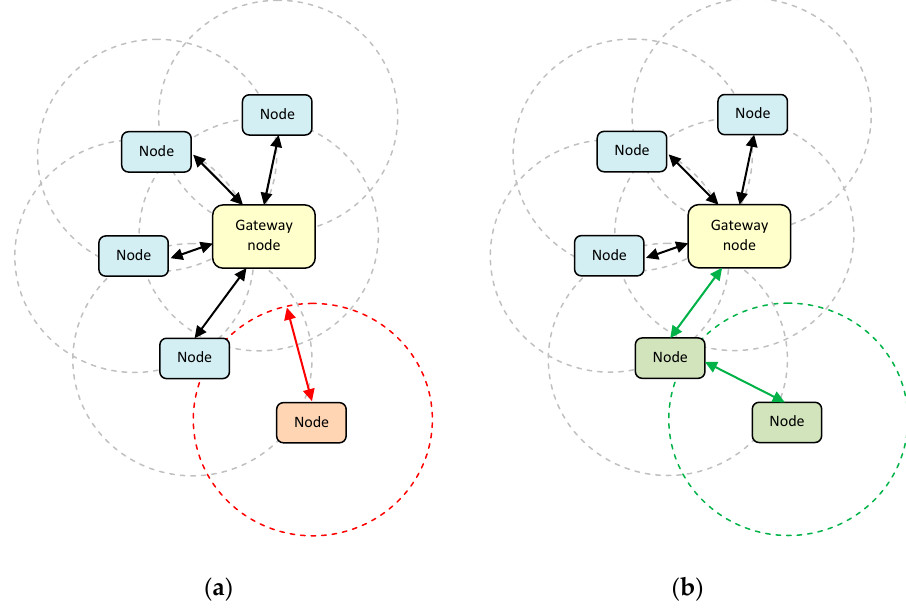
Figure 7. Direct ( a ) and indirect ( b ) types of communication.